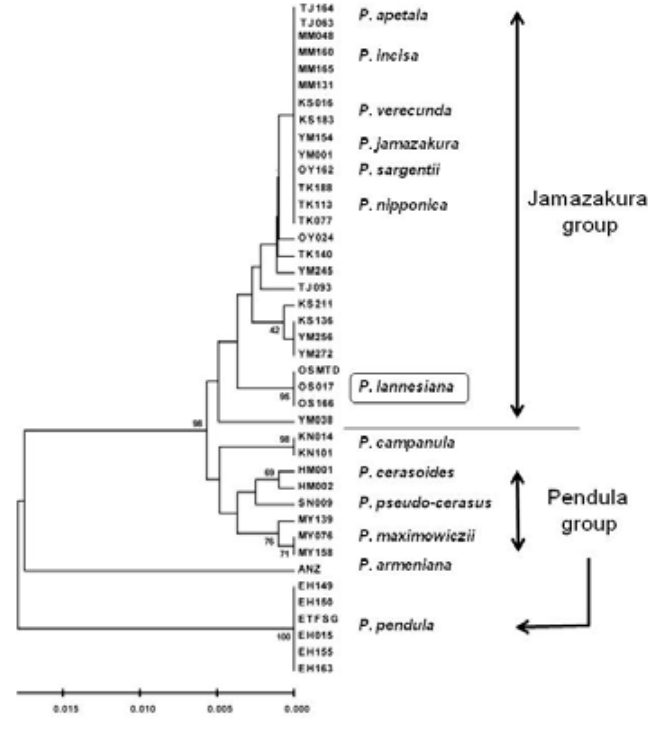
Fig. 4 - Phylogenetic UPGMA tree of the intron 19 sequences in the PolA1 genes from 40 individuals in nine Cerasus species. Indi- viduals used are listed in Table 1.